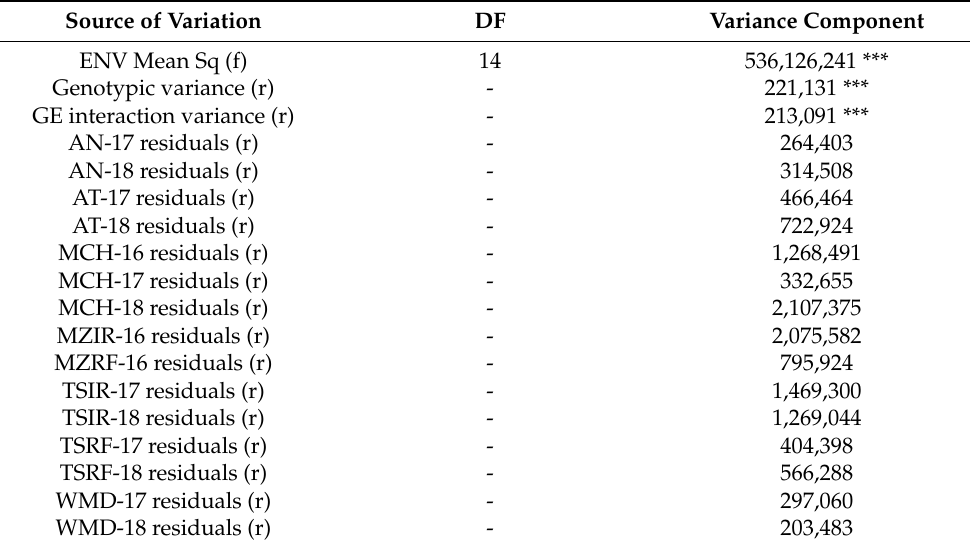
Table 3. Combined analysis of variance from the linear mixed model of durum wheat lines derived from interspecific crosses and checks grown in contrasted environments in Morocco and Sudan. Source of Variation DF Variance